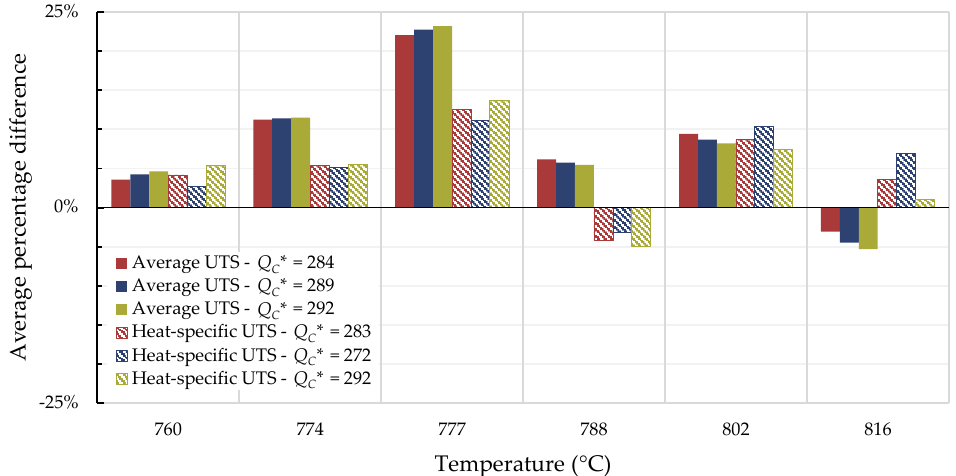
Figure 9. Average percentage difference at each temperature for Nimonic 105 using all data to calculate 𝑄 𝐶∗ (kJ/mol).